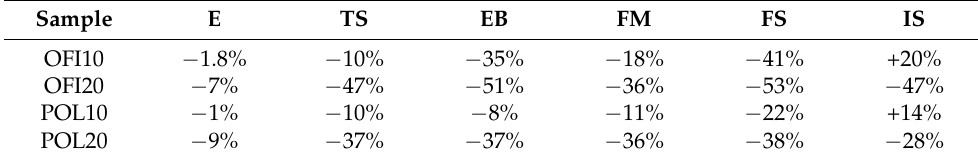
Table 6. Relative variations of the main mechanical properties in the